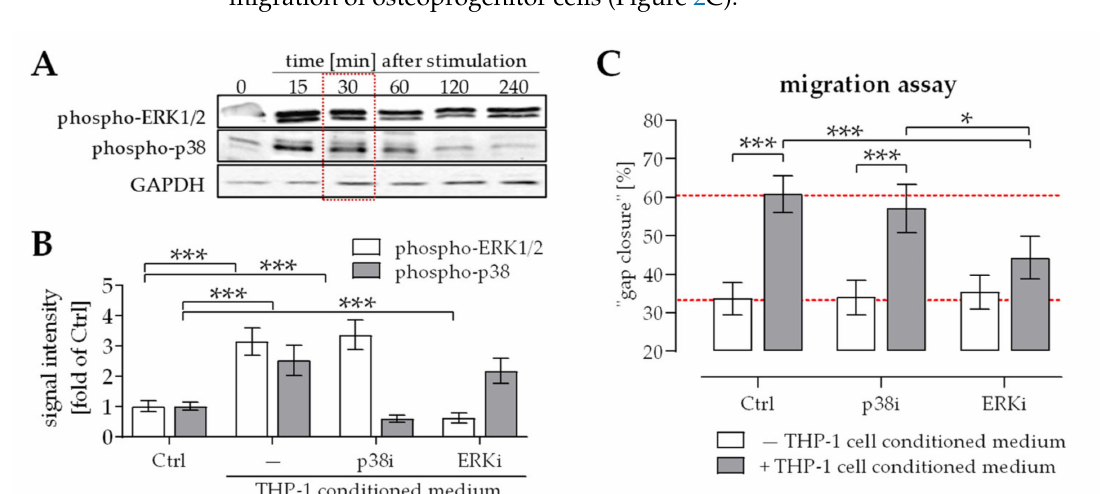
Figure 2. ERK1/2 activation is required for THP-1 cell-favored migration of osteoprogenitor cells. ( A ) Representative Western blot images showing ERK1/2 and p38 phosphorylation in osteoprogenitor cells 0, 15, 30, 60, 120, and 240 min after stimulation with THP-1 cell conditioned medium. ( B ) ImageJ was used to quantify ERK1/2 and p38 phosphorylation (PathScan ® Intracellular Signaling Array) in SCP-1 cells 30 min after stimulation with THP-1 cell conditioned medium in the absence (Ctrl) or presence of p38 inhibitor (p38i) SB203580 or ERK1/2 inhibitor (ERKi) U0126. ( C ) Migration of osteoprogenitor cells was determined using a scratch assay. Data are presented as bar chart (mean ± 95% C.I.). N = 3 and n = 3. Data were compared by non-parametric 2-way ANOVA, followed by Sidak’s multiple comparison test. * p < 0.05 and *** p < 0.0001 as